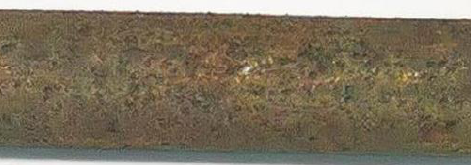
Figure 9. Macroscopic surface of corroded steel wire.